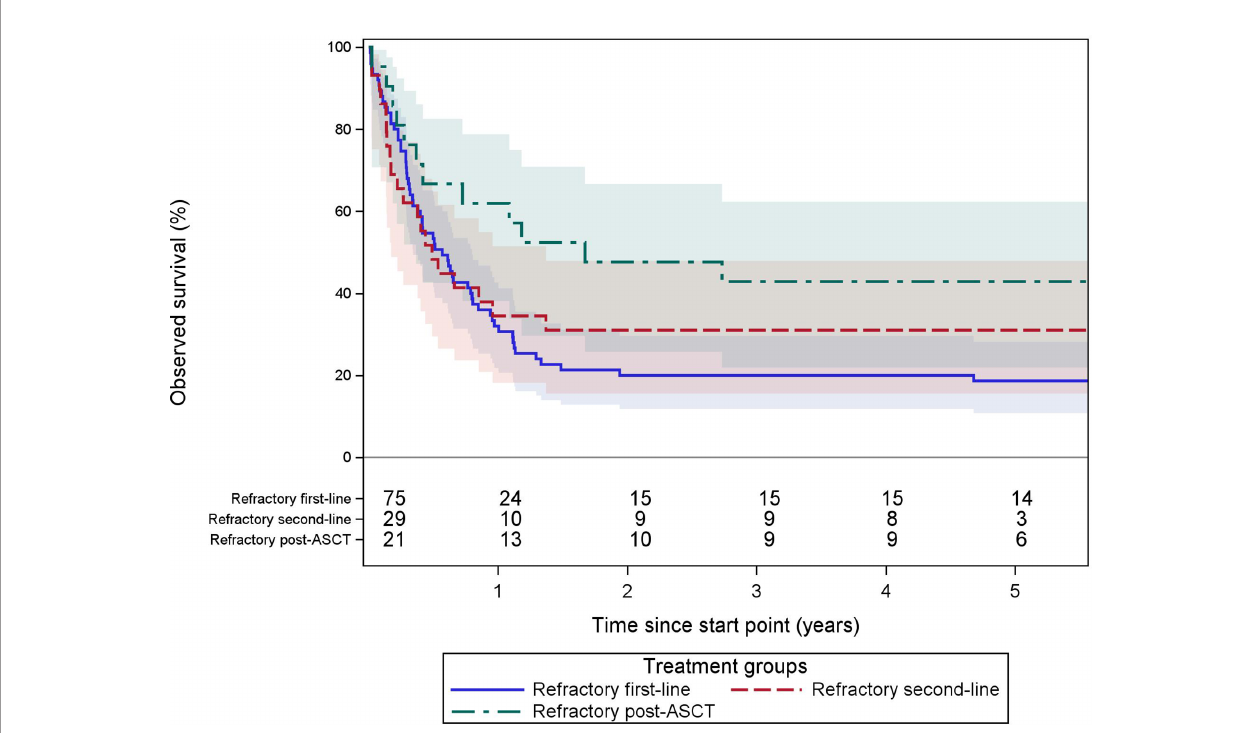
FIGURE 6 | Observed survival of refractory DLBCL patients. These Kaplan – Meier curves show the observed survival from the start of second- or further-line of therapy strati fi ed in 3 groups. In blue, patients starting any second-line regimen <12 weeks after the end of ≥ 4 cycles of any fi rst line regimen (n = 75). In red, patients starting a third line regimen <12 weeks after ≥ 2 cycles of any second-line regimen (n = 29). In green, patients starting any therapy (radiotherapy, chemotherapy, or HSCT) <12 months after start of ASCT (ASCT within 2 years from incidence) (n = 23). The starting point for each group is different and de fi ned as the start of the fi rst (salvage) therapy after becoming refractory. Treatments were only considered during the 2 years of follow-up after for diagnosis. The numbers of patients at risk are tabled below the curves. Colored areas represent the 95% con fi dence intervals.